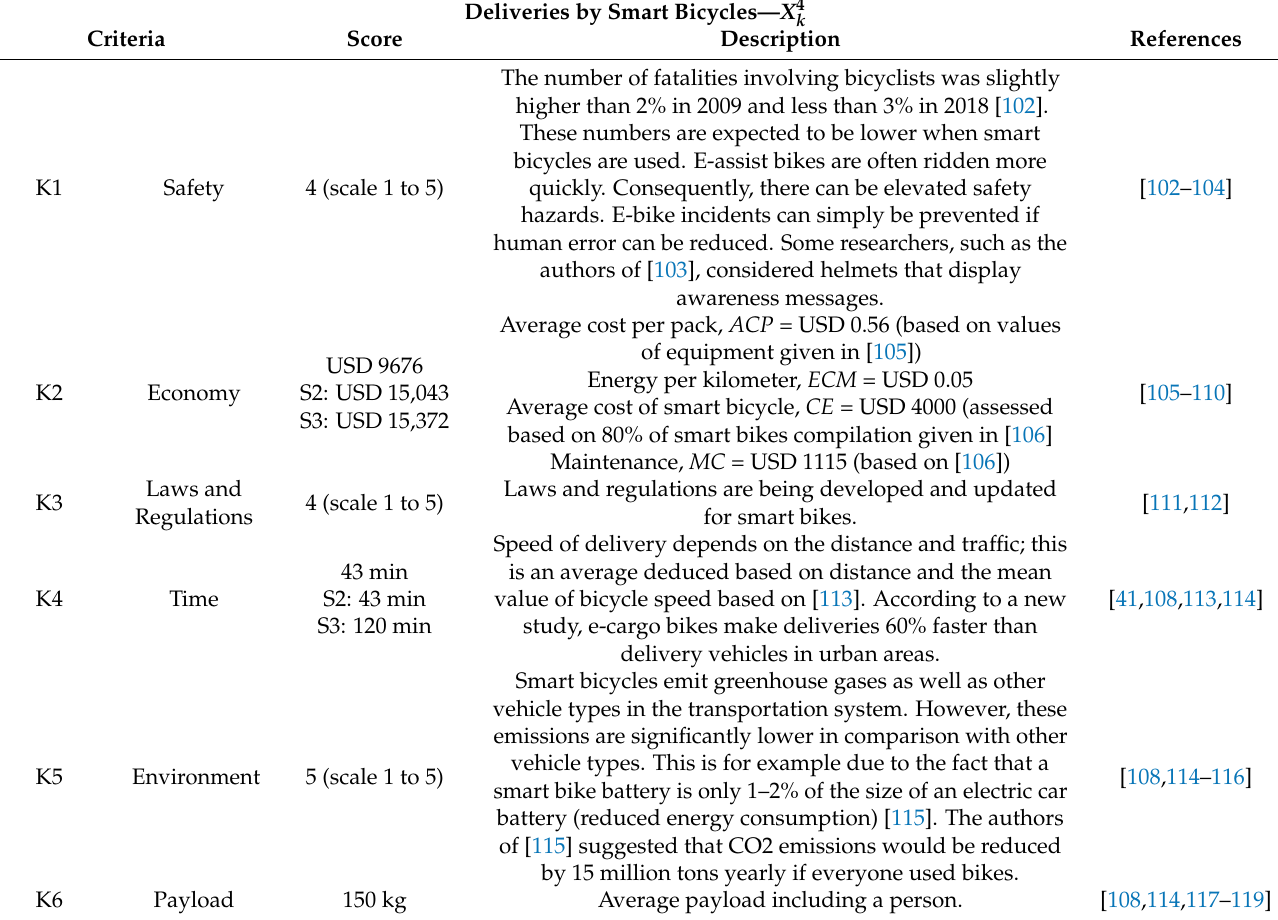
Table 5. Smart bicycle scores in the case of S1 (unless otherwise